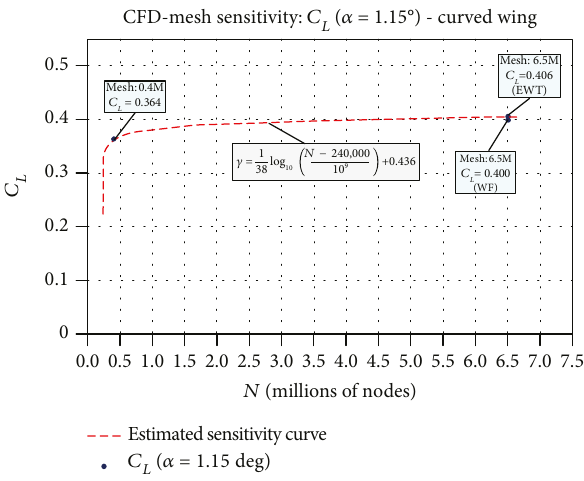
Figure 17: CFD mesh sensitivity — C